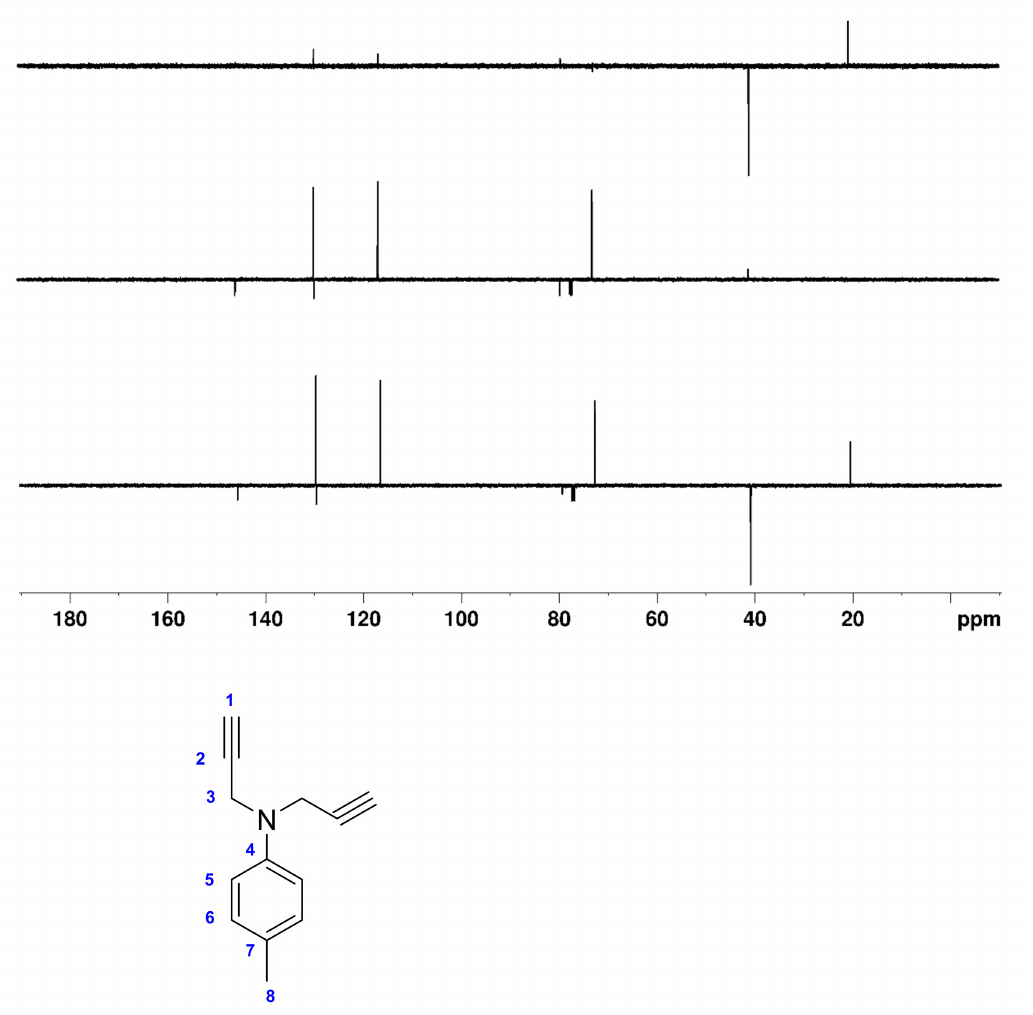
Figure 7. Bottom : DEPTQ + 45 90 ; middle : DEPTQ + 90 45 ; top : Difference between DEPTQ + 45 90 and DEPTQ + 90 45 spectra of ~30 mg of 4-methyl- N,N -di(prop-2-yn-1-yl)aniline dissolved in 0.7 mL CDCl 3 . The delays δ 1 , δ 2 , and δ 3 were set to 2.18 ms, adjusted for a coupling constant 1 J CH of 230 Hz, to 4.00 ms, adjusted for a coupling constant 1 J CH of 125 Hz, and to 3.18 ms, adjusted for a coupling constant 1 J CH of 165 Hz, respectively. The relaxation delay was 4 s, the NOE building period 3s. All other parameters are identical to those described in the Materials and Methods section. The structure of 4-methyl- N,N -di(prop-2-yn-1-yl)aniline and carbon numbering is shown below the